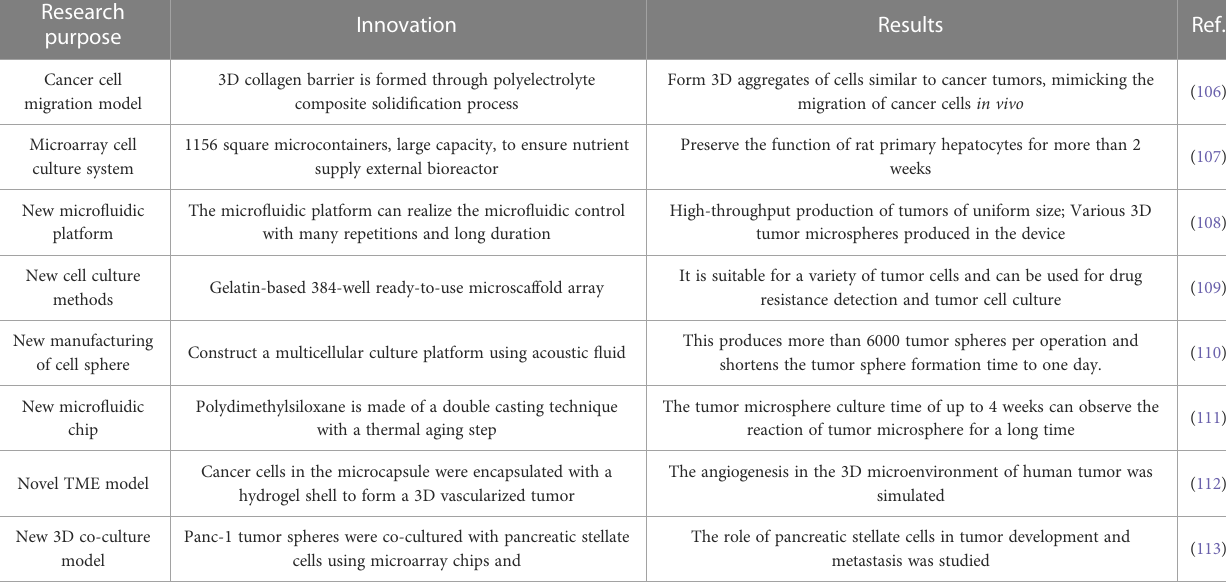
TABLE 4 New progress of micro fl uidic